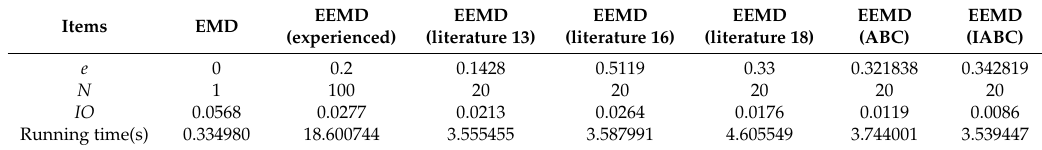
Table 2. Indicator values after decomposition by different